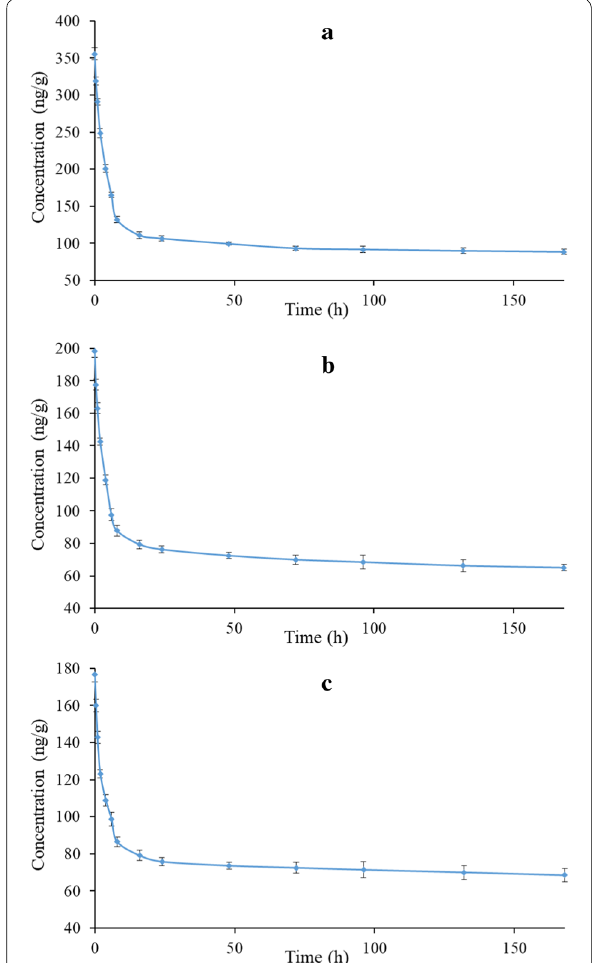
Fig. 2 The depuration rates of mixtures of CdS/ZnS QDs located on mangrove ( Kandelia obovata (S., L.) Yong) root epidermis with the sterilization treatment a oleic acid-CdS/ZnS QDs, b PEG-COOH-CdS/ ZnS QDs and c MPA-COOH-CdS/ZnS